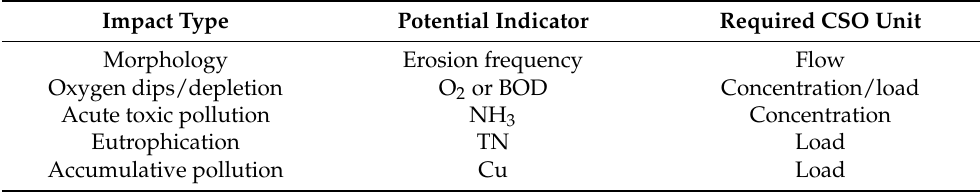
Table 1. CSO impact types with potential indicators and required parameters (after